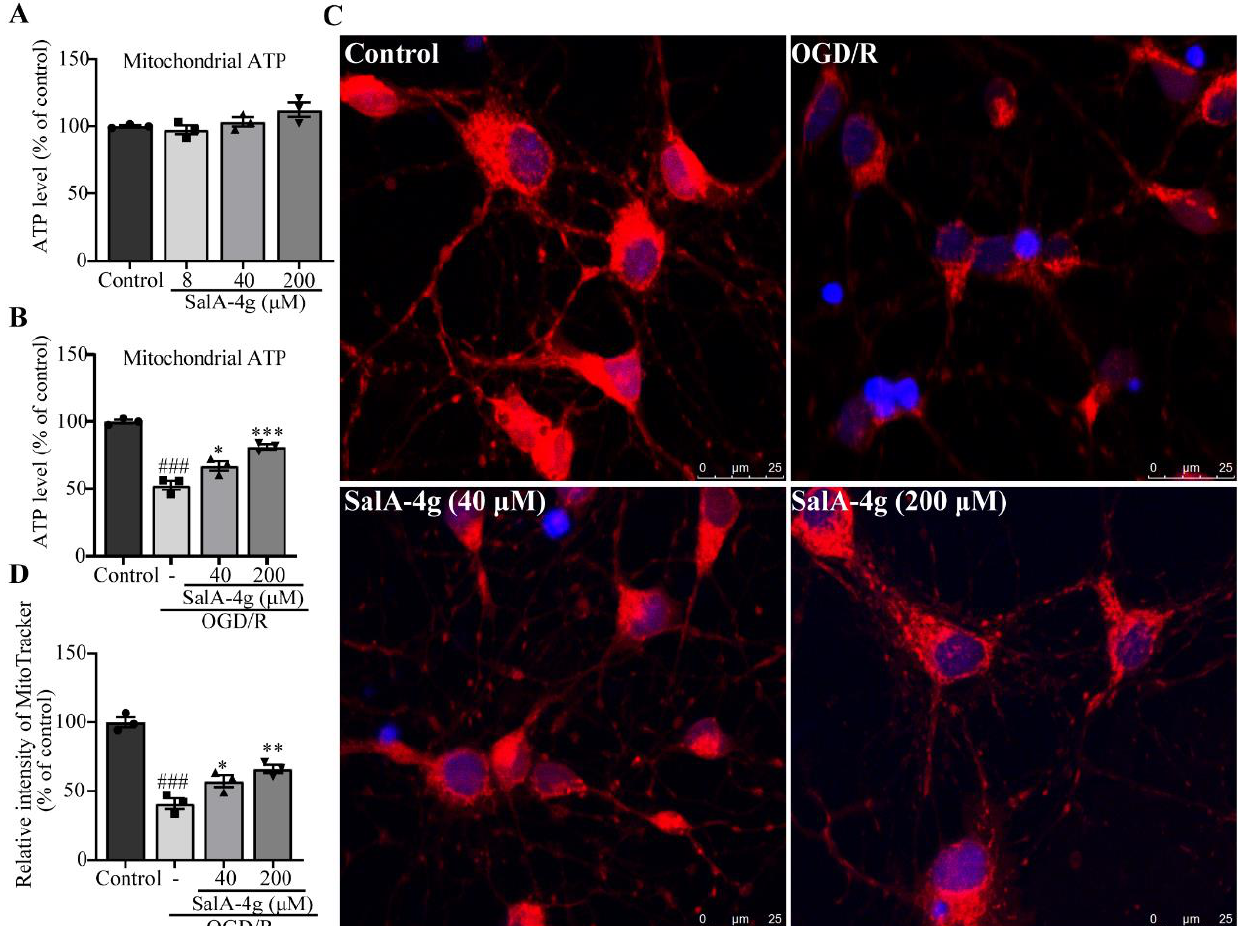
Figure 2. SalA-4g enhances mitochondrial bioenergy and activity in cortical neurons under OGD/R stress. ( A ) Histogram depicting the mitochondrial ATP levels in neurons exposed to different concentrations of SalA-4g for 24 h. ( B ) Histogram depicting the mitochondrial ATP levels of control cells, cells exposed to 2.5 h of OGD and 24 h of reoxygenation alone, and cells treated with different concentrations of SalA-4g during the OGD/R period. ( C ) Representative immunofluorescence of Mito-Tracker staining. Scale bar, 25 μm. ( D ) Histogram depicting the relative fluorescence intensity of Mito-Tracker in different groups. All values are presented as mean ± SEM ( n = 3); ### p < 0.001 versus control; * p < 0.05, ** p < 0.01, *** p < 0.001 versus OGD/R alone.